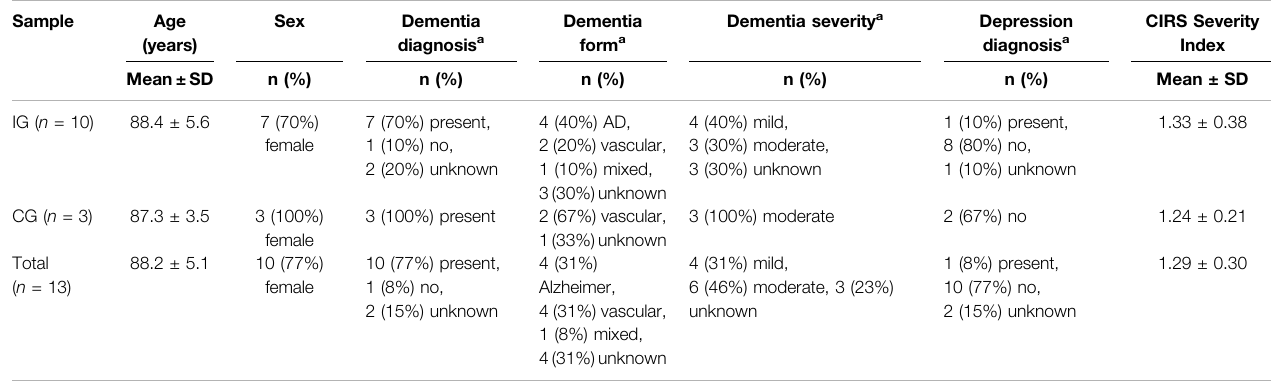
TABLE 5 | Sample characteristics of